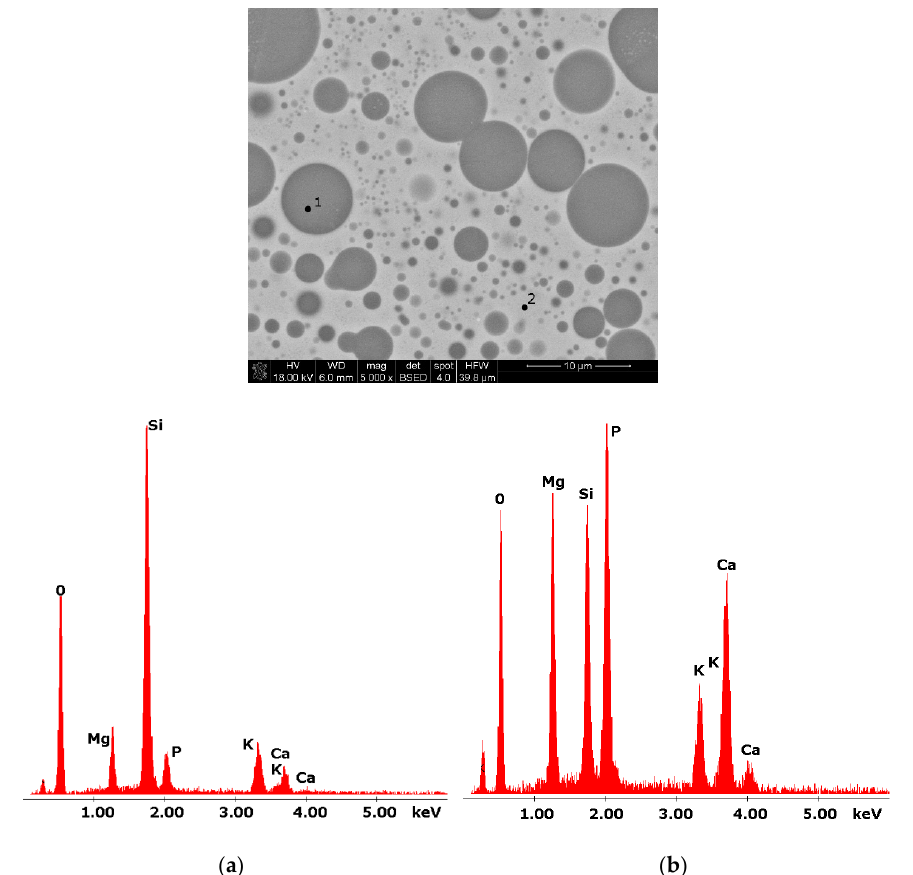
Figure 3. SEM microphotograph of 15B glass. (5000×) ( a ) EDS analysis of 15B glass (p.1); ( b ) EDS analysis of 15B glass (p.2).